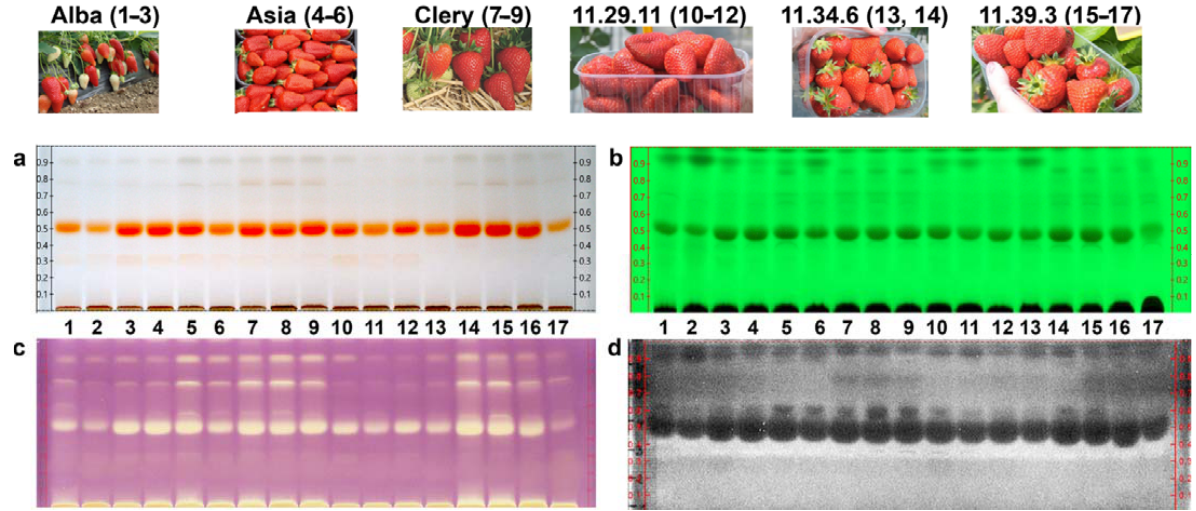
Figure 1. HPTLC profiles of 17 strawberry samples of six different cultivars ( a ) at white light illu ‐ mination, ( b ) at 254 nm, ( c ) after the DPPH• scavenging assay and ( d ) Aliivibrio fischeri bioassay. illumination, ( b ) at 254 nm, ( c ) after the DPPH • scavenging assay and ( d ) Aliivibrio fischeri